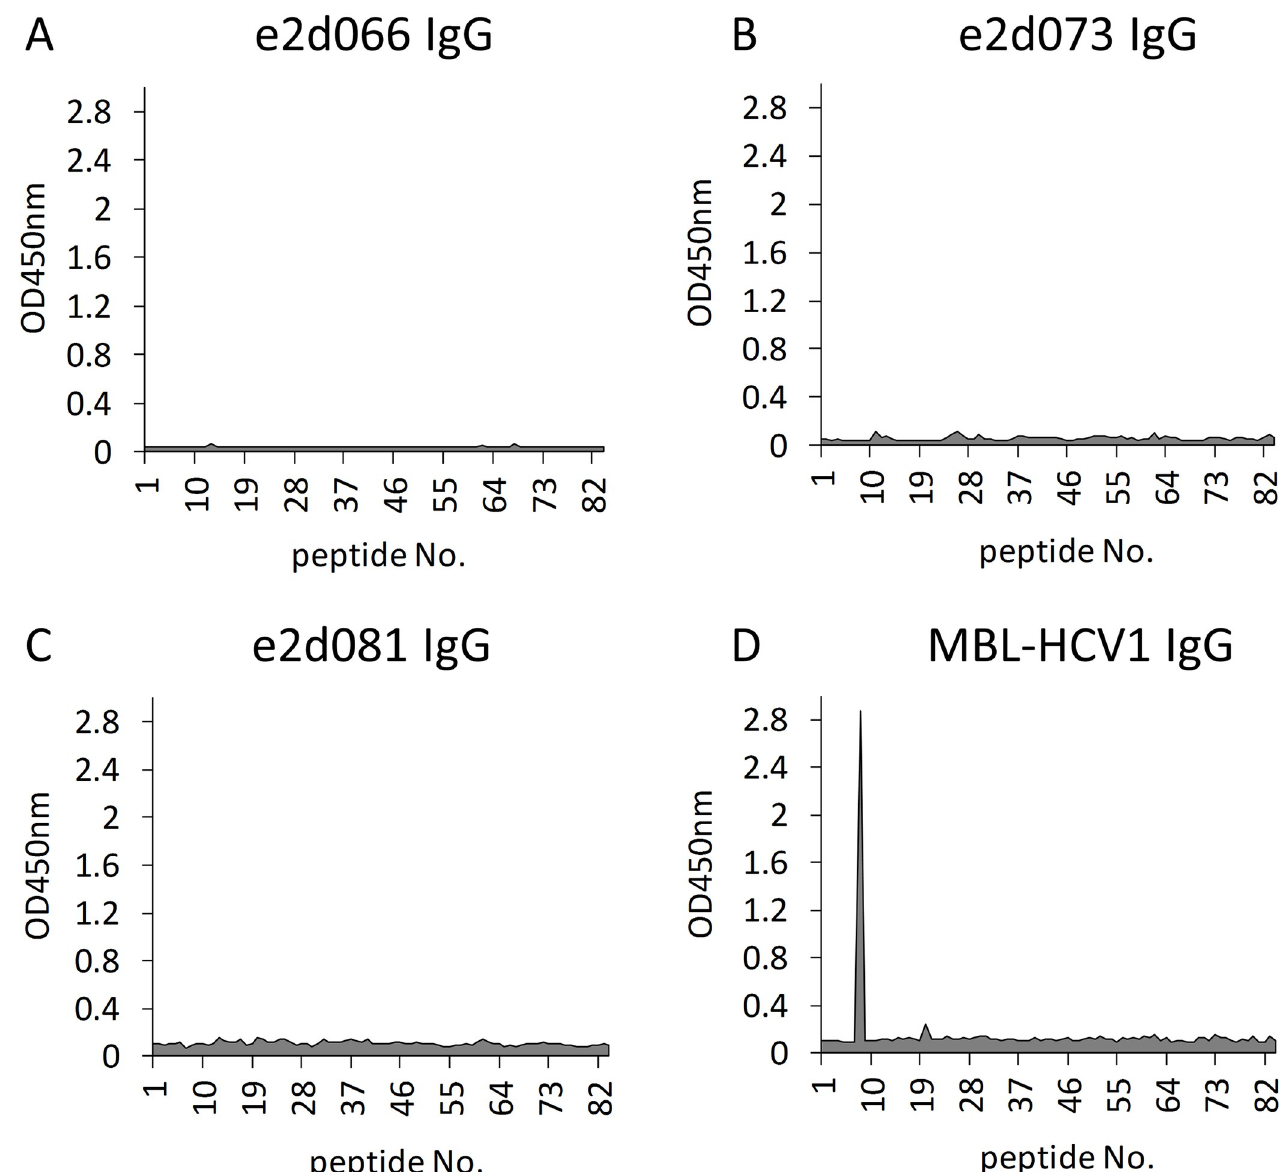
Fig 2. Epitope analysis with overlapping peptides. A continuous series of TH E2 12-mer peptides (peptide Nos. 1 to 82), staggered by 3 amino acids each, were synthesized. Each peptide was modified to carry a biotinylation at the N-terminus and a glycine amide at the C-terminus. These peptides were used to coat a streptavidin-coated plate. (A) e2d066, (B) e2d073, (C) e2d081, or (D) MBL-HCV1 antibodies were applied to the peptide-coated plates. HRP-conjugated goat anti-human IgG antibody (Thermo Fisher Scientific) was used to detect the peptide-bound antibodies. The titers of bound antibodies were measured using a peroxidase assay kit (Type T; Sumitomo Bakelite Co., Ltd., Tokyo, Japan). overlapping epitopes. On the other hand, the e2d073 IgG, the AR3A antibody, the MBL-HCV1